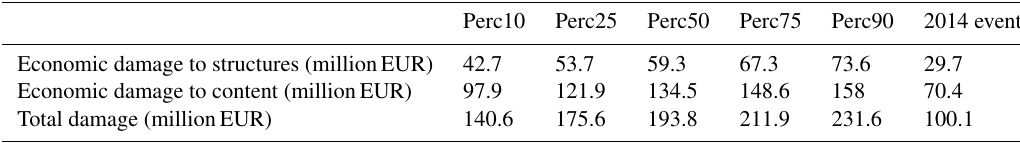
Table 2. Economic damage estimated for the considered flooding scenarios compared with damage estimated for the event on 9 October 2014.